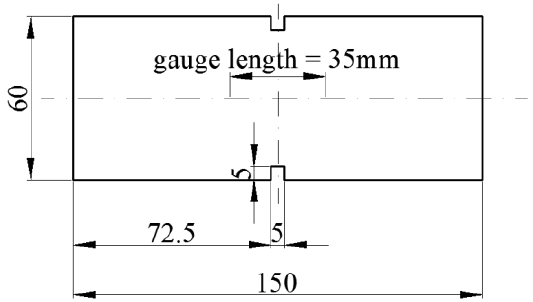
Figure 7. Geometry of specimen in the uniaxial tension test; dimensions in (mm).